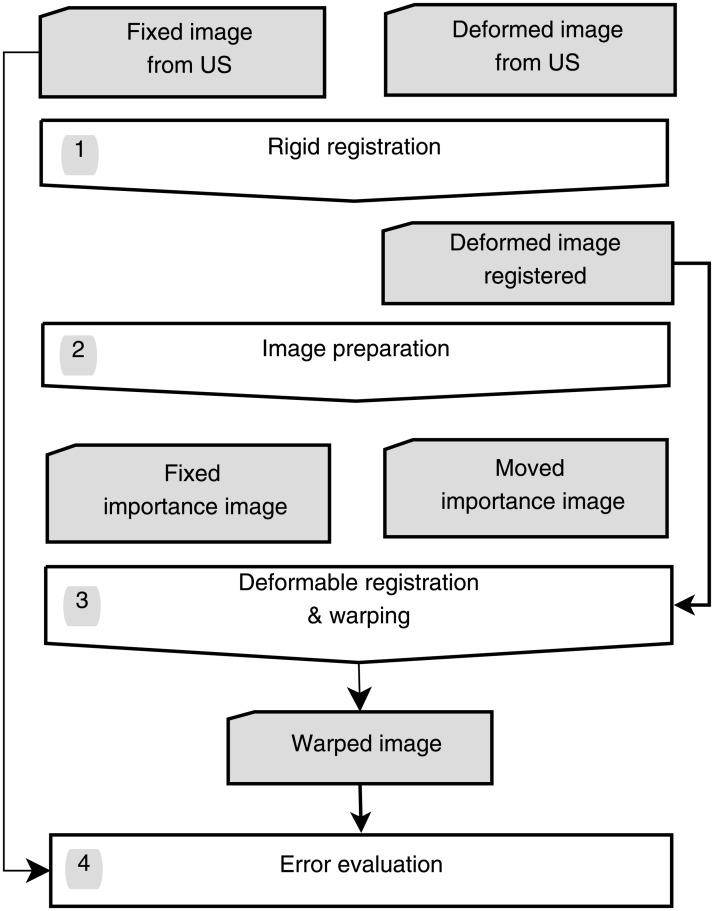
Work flow showing the deformable registration process and the error evaluation.